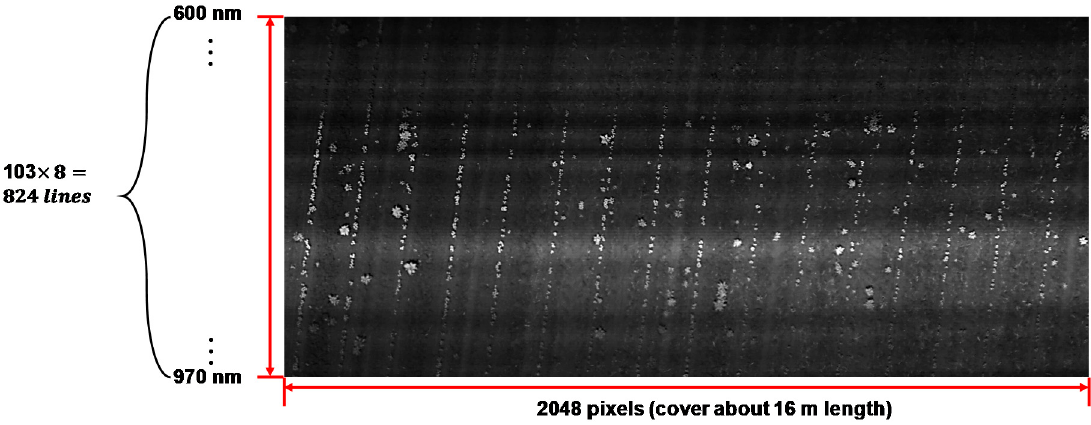
Figure 2. One raw image includes 103 spectral bands in the range of 600–970 nm with eight spectral lines per band. Each spectral line includes 2048 pixels in the horizontal direction, resulting in an effective resolution of 824 × 2048 pixels for each raw image.